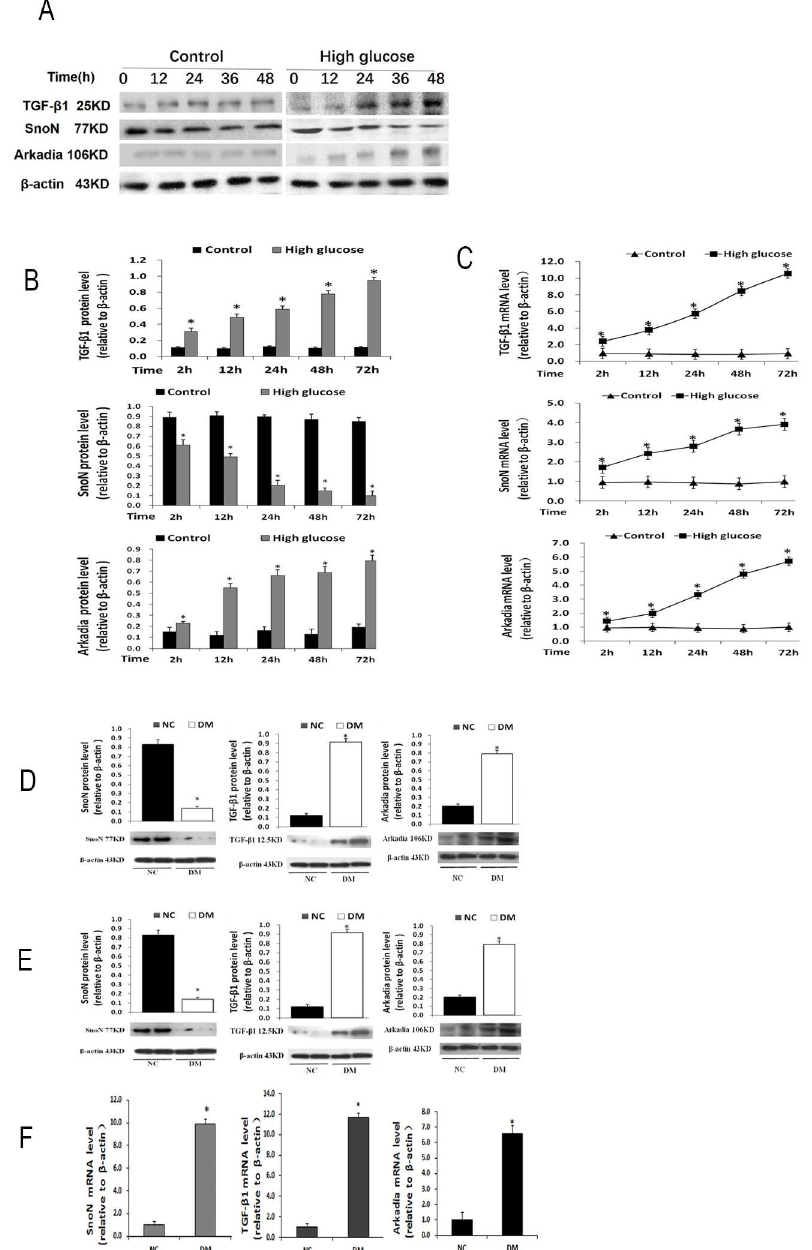
Fig 3. High glucose stresssuppressesSnoN while activating TGF- β 1 and Arkadia in renal tubular epithelial cells and a rat model of diabetes mellitus. A, B, TGF- β 1, SnoN and Arkadia protein levels determined by Western blot in NRK52E cells treated with 25 mmol/L glucosefor 2, 12, 24, 48 or 72h. * P < 0.05 vs respectiveNRK52E cells treated with 5.5 mmol/L glucosefor the same time. C, TGF- β 1, SnoN and Arkadia mRNA amounts determined by qRT-PCR in NRK52E cells treated with 25 mmol/L glucosefor 2, 12, 24, 48 or 72h. * P < 0.05,vs. respectiveNRK52E cells treated with 5.5 mmol/L glucoseat 2h. D, SnoN, TGF- β 1 and Arkadia protein levels determined by Western blot in kidney tissues. * P < 0.05,vs. respectivenormal control group. E, SnoN, TGF- β 1 and Arkadia mRNA levels determinedby qRT-PCR in kidney tissues. * P < 0.05,vs. respectivenormalcontrol group.